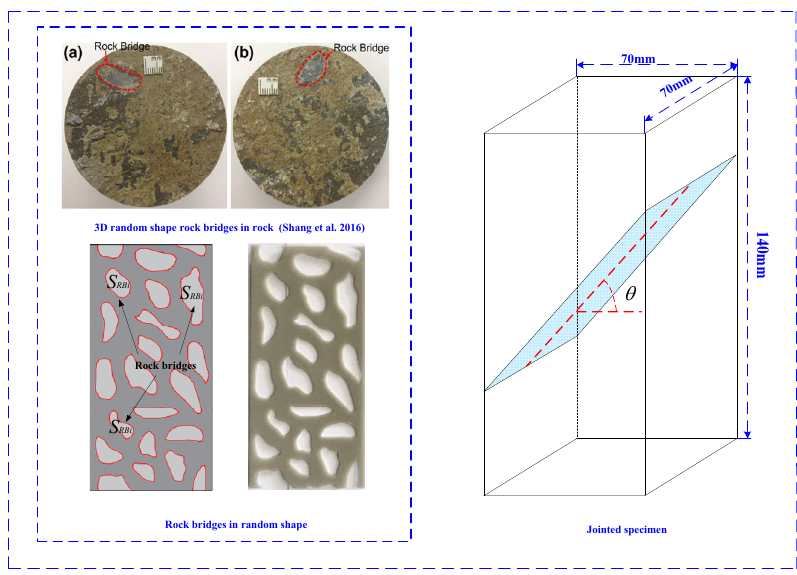
Figure 2. 3D nonpersistent joint and jointed specimen [20].